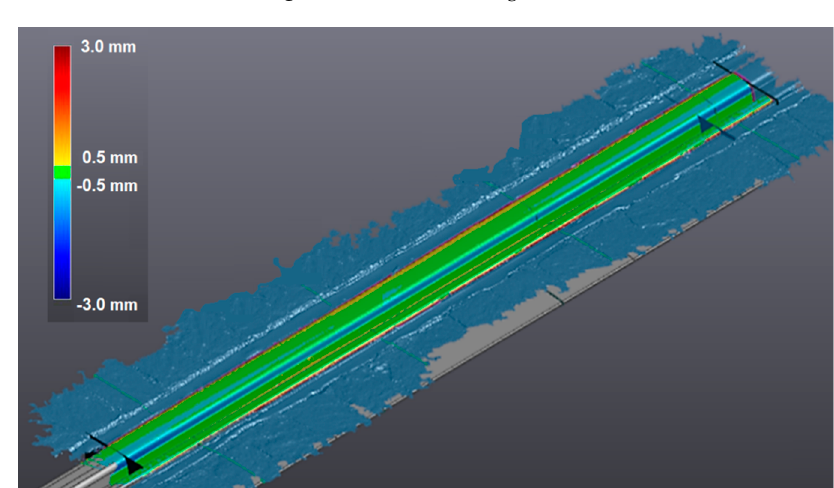
Figure 16. Color map of deviations.